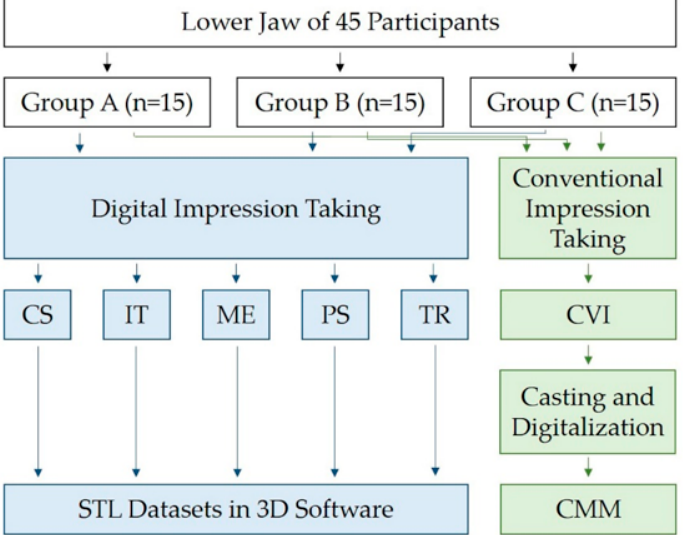
Figure 1. Flow scheme of the clinical trial (CS = CS 3800, IT = iTero Element 5D, ME = Medit i700, PS = Primescan, TR = Trios 4, CVI = conventional impression, STL = standard tessellation language, CMM = coordinate measuring machine).